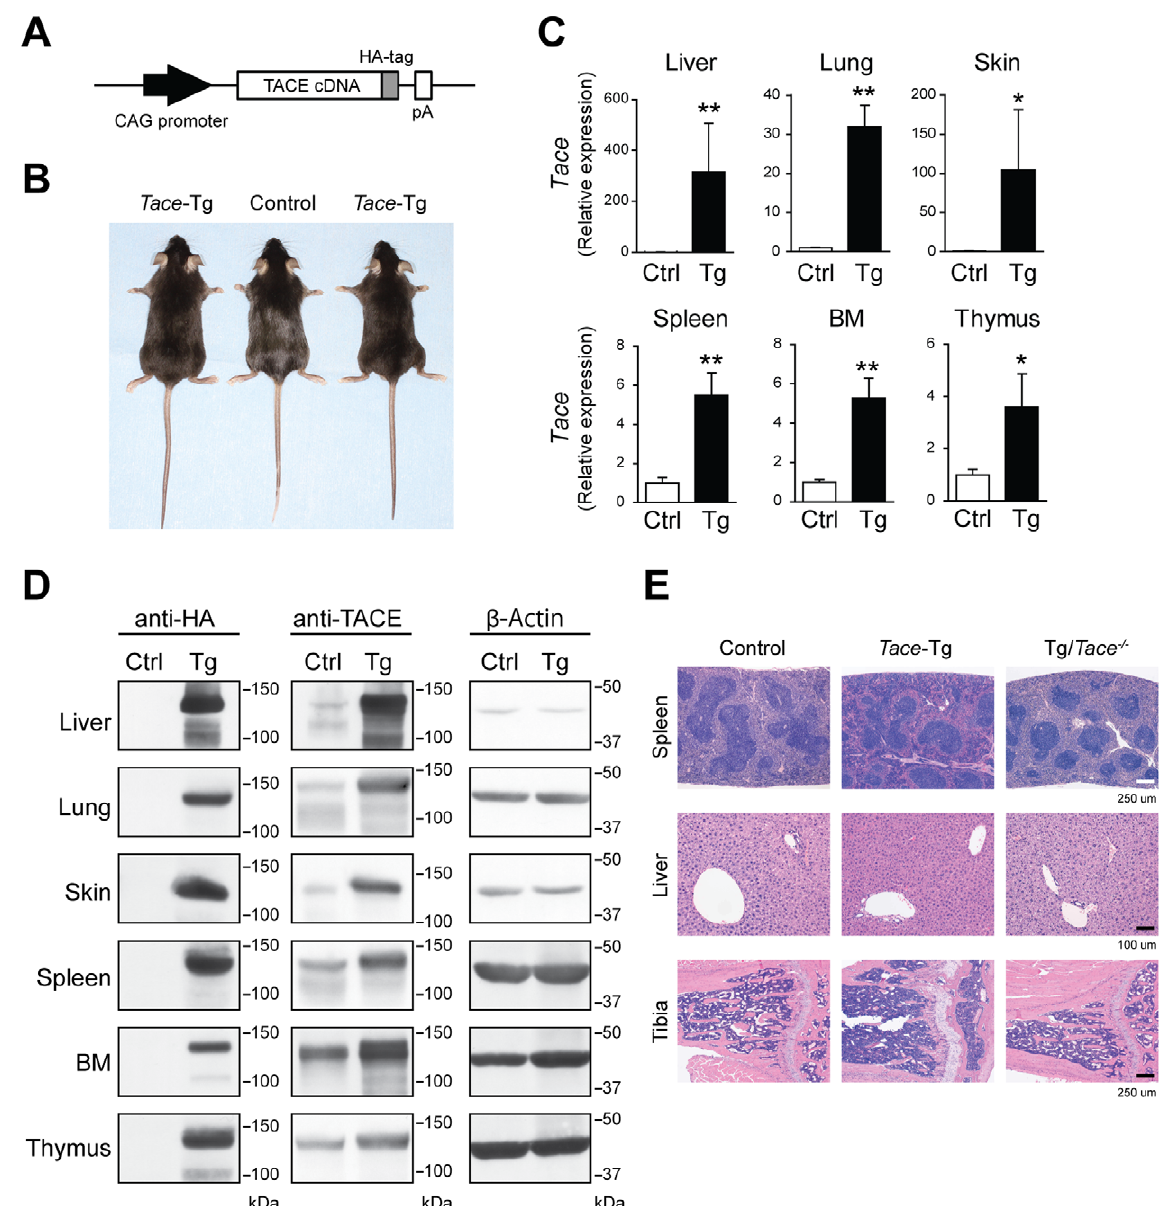
Figure 1. The systemic overexpression of TACE causes no overt defects. (A) A schematic of the transgene construct. pA, polyadenylation signal sequence. (B) Gross morphology of the 8-week-old control (Ctrl) and Tace -Tg (Tg) mice. (C) Quantitative RT-PCR analysis of Tace expression in the liver, lung, skin, spleen, bone marrow cells (BM), and thymus from 8-week-old control (Ctrl) and Tace -Tg (Tg) mice. The expression level of Tace in each organ of the control mice is set to 1. Bars, S.D. *p , 0.05. **p , 0.005. (D) Western blot analysis using anti-HA, anti-TACE, and anti- b -Actin antibodies. (E) Hematoxylin and eosin-stained sections of the spleen, liver, and tibia from 8-week-old control, Tace -Tg, and Tace -tg/ Tace 2 / 2 (Tg/ Tace 2 / 2 )